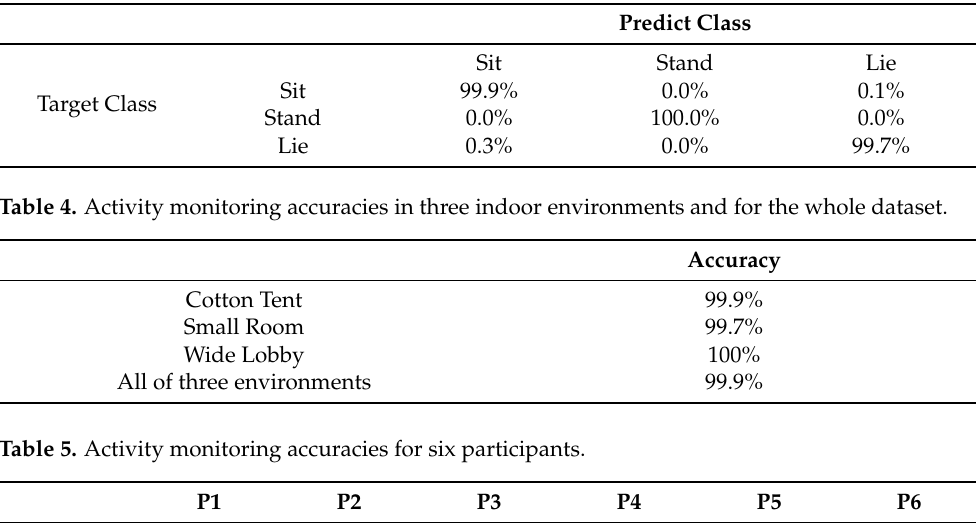
Table 3. Confusion matrix of classification on three activities.